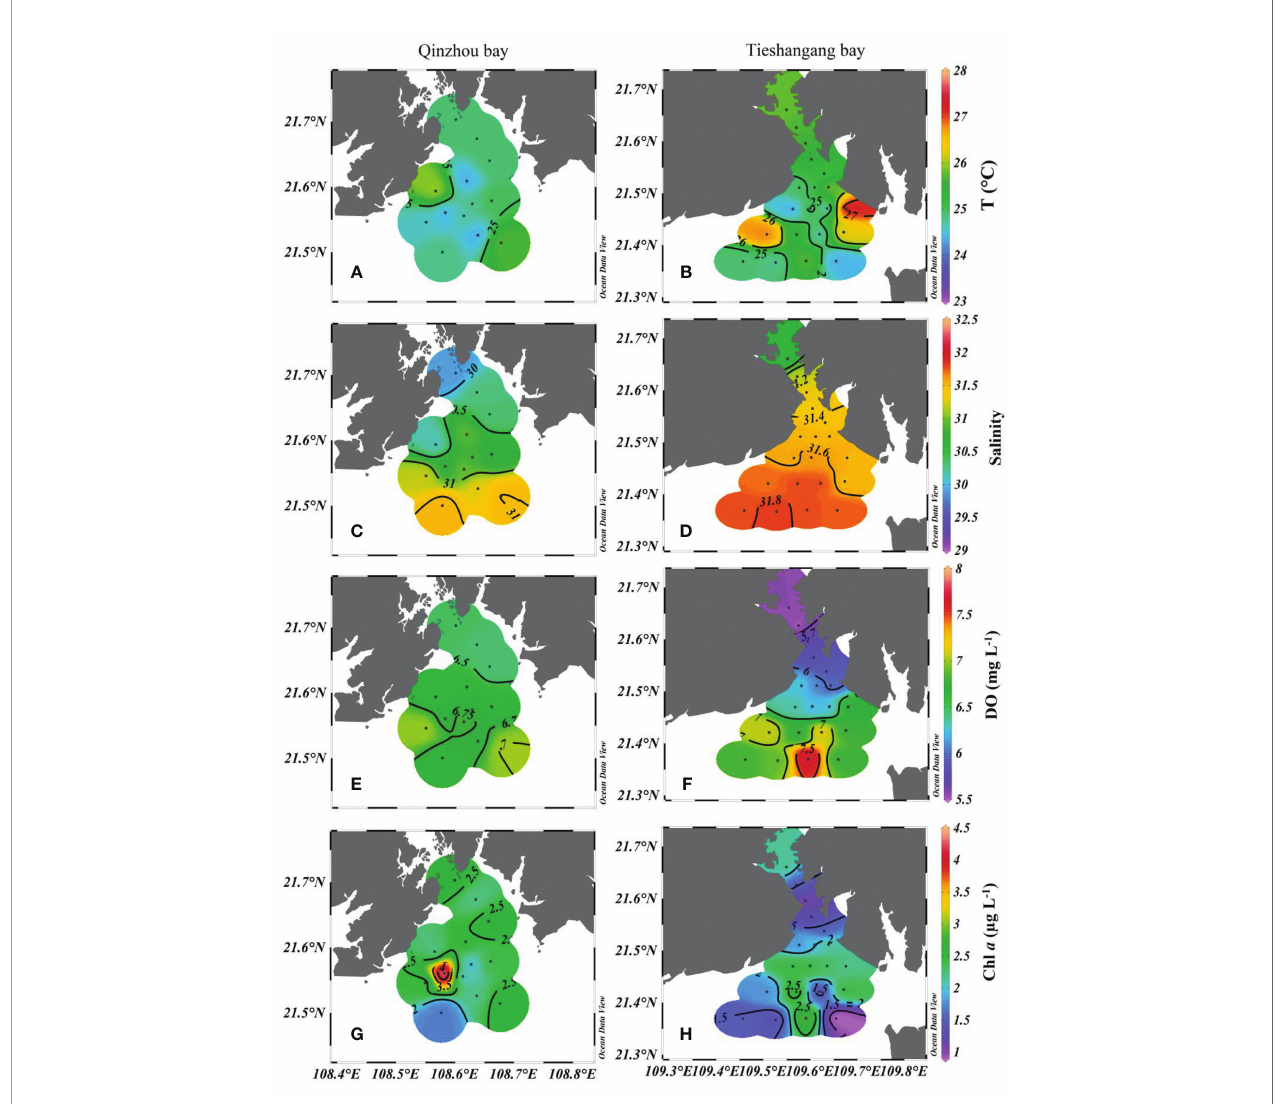
FIGURE 2 | Spatial distributions of temperature (A, B) , salinity (C, D) , DO (E, F) and Chl a level (G, H) in Qinzhuo Bay and Tieshangang Bay during the